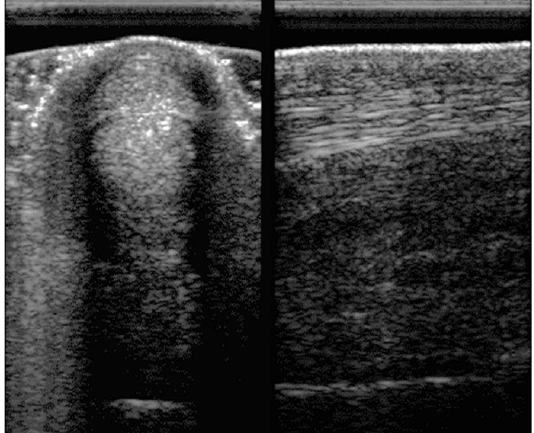
Figure 9. Illustration of ultrasonographic lesion characterization summarized in Table 7. Longitudinal fiber alignment and cross-sectional area echogenicity loss is presented [27]. Ultrasound images at Day 1 and at Day 30 clearly illustrate the evolution of tendon regeneration. Changes in echogenicity, fiber alignment, and cross-sectional area are evi- dent, as seen in Figure 10.